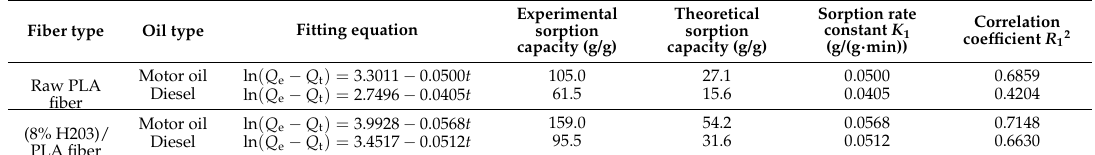
Figure 11. Linear fitting curve of first-order kinetic law of Lagergren model (( a ) raw PLA fiber; ( b ) (8% H203)/PLA fiber). Table 3. Parameters of oil sorption kinetics of first-order kinetic law of the Lagergren model.